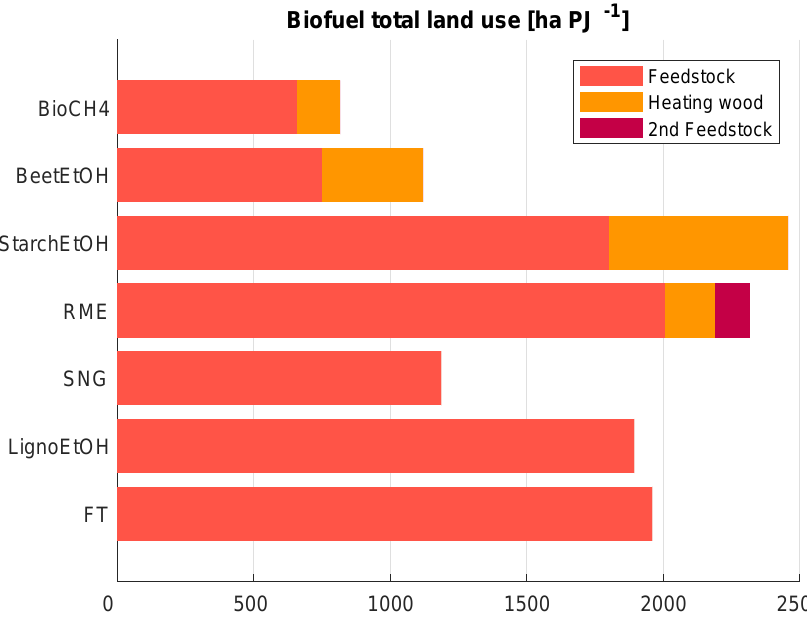
Figure 4. Biofuel land requirement by source in the first year of the base case.